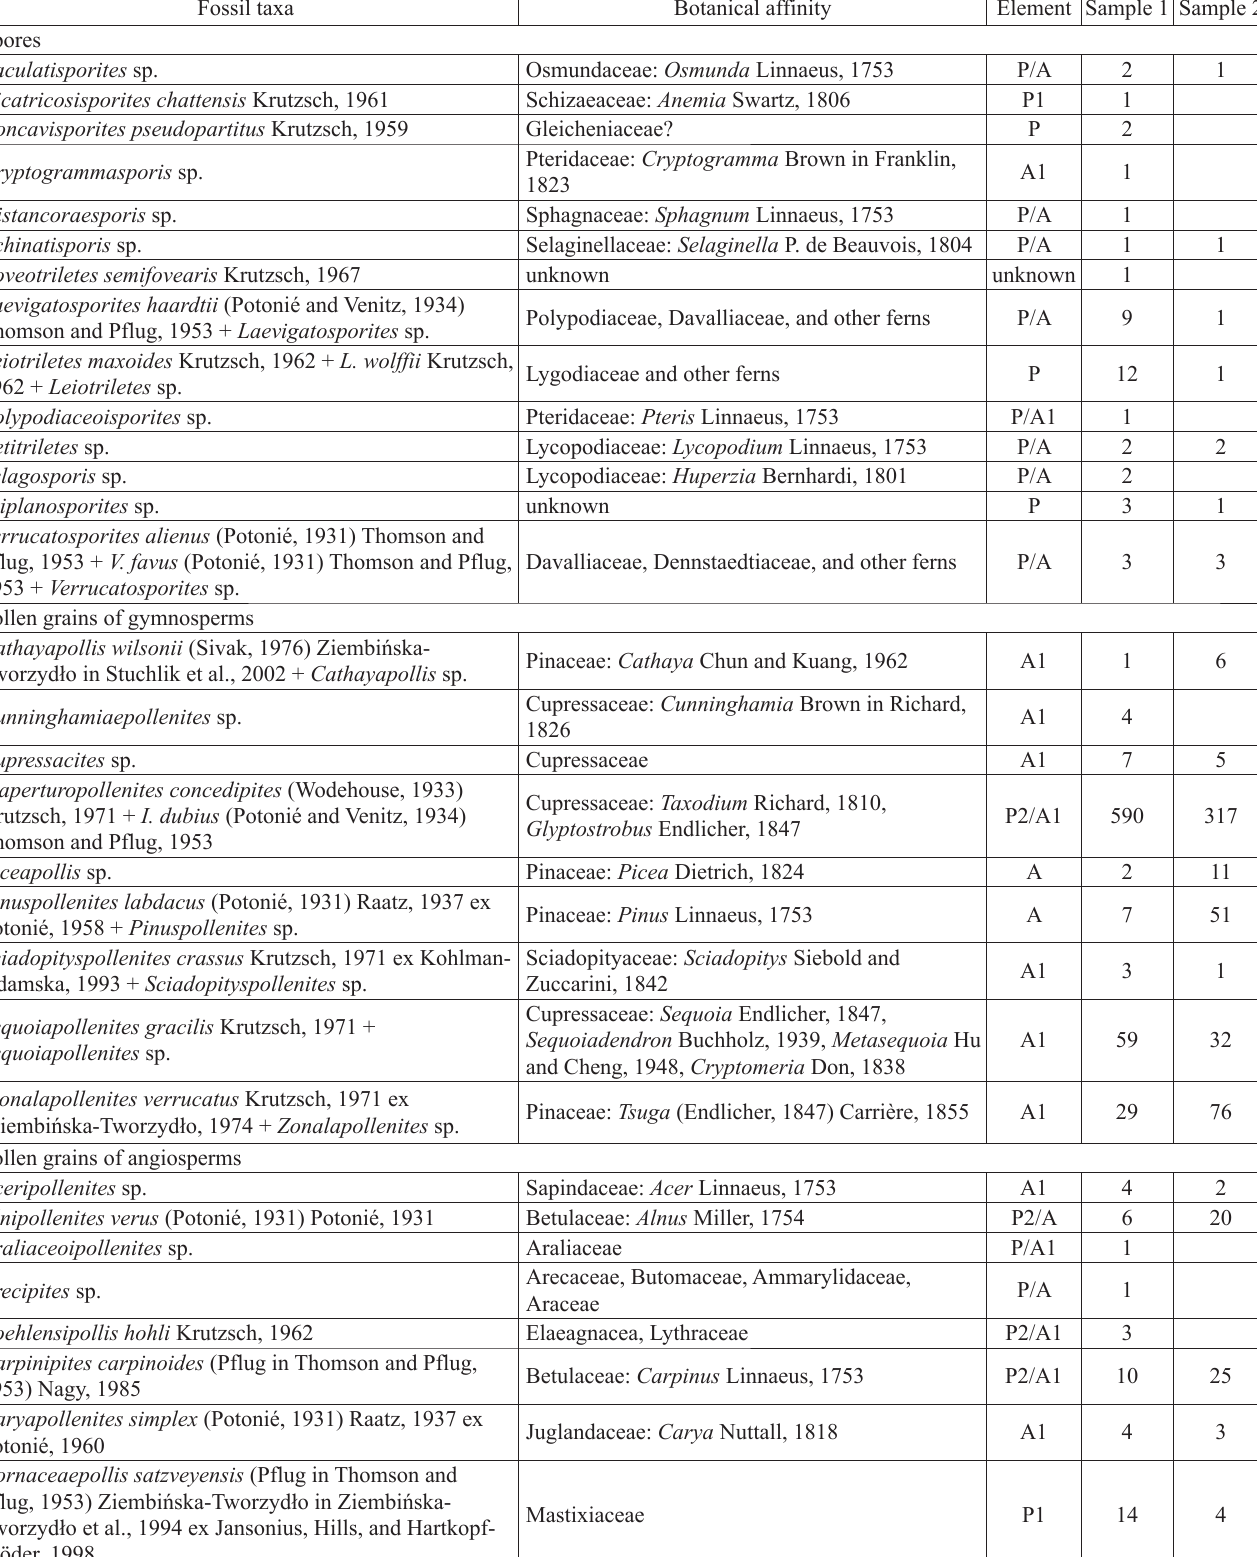
Table 2. Spores, pollen grains, non-pollen palynomorphs, and palynoclasts recorded in palynological samples from the R ę biszów. Taxonomy and botanical affinity according to Stuchlik et al. (2001, 2002, 2009, 2014). The following paleofloristical elements have been